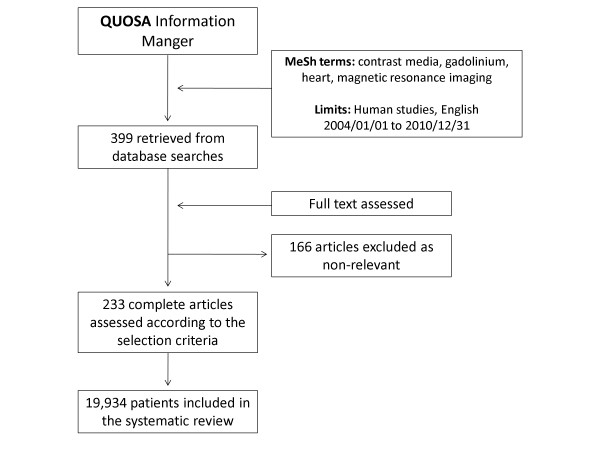
Flow diagram of review identification and selection of patients include meta-analysis.